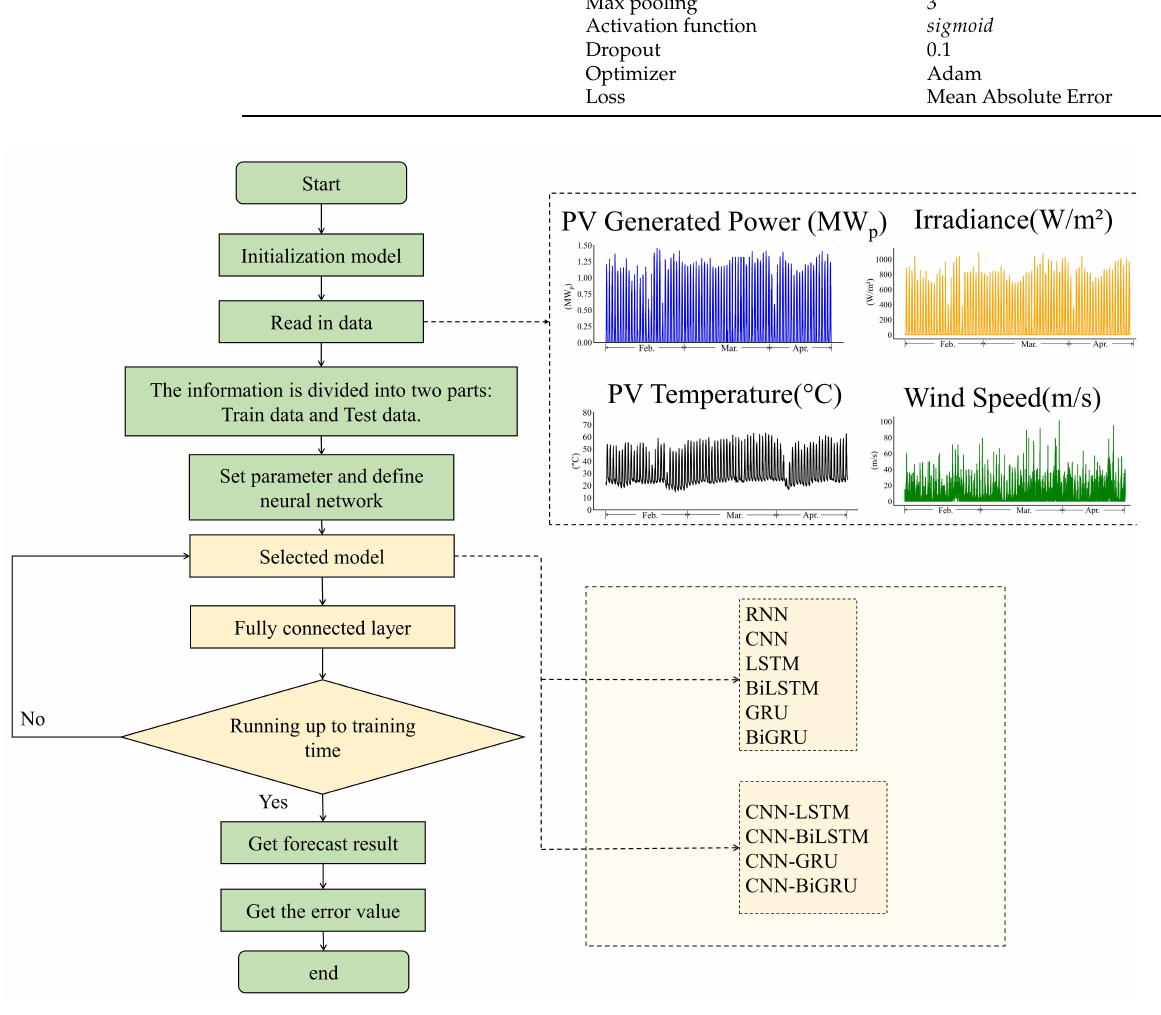
Figure 3. Flow chart for implementation of the proposed deep learning